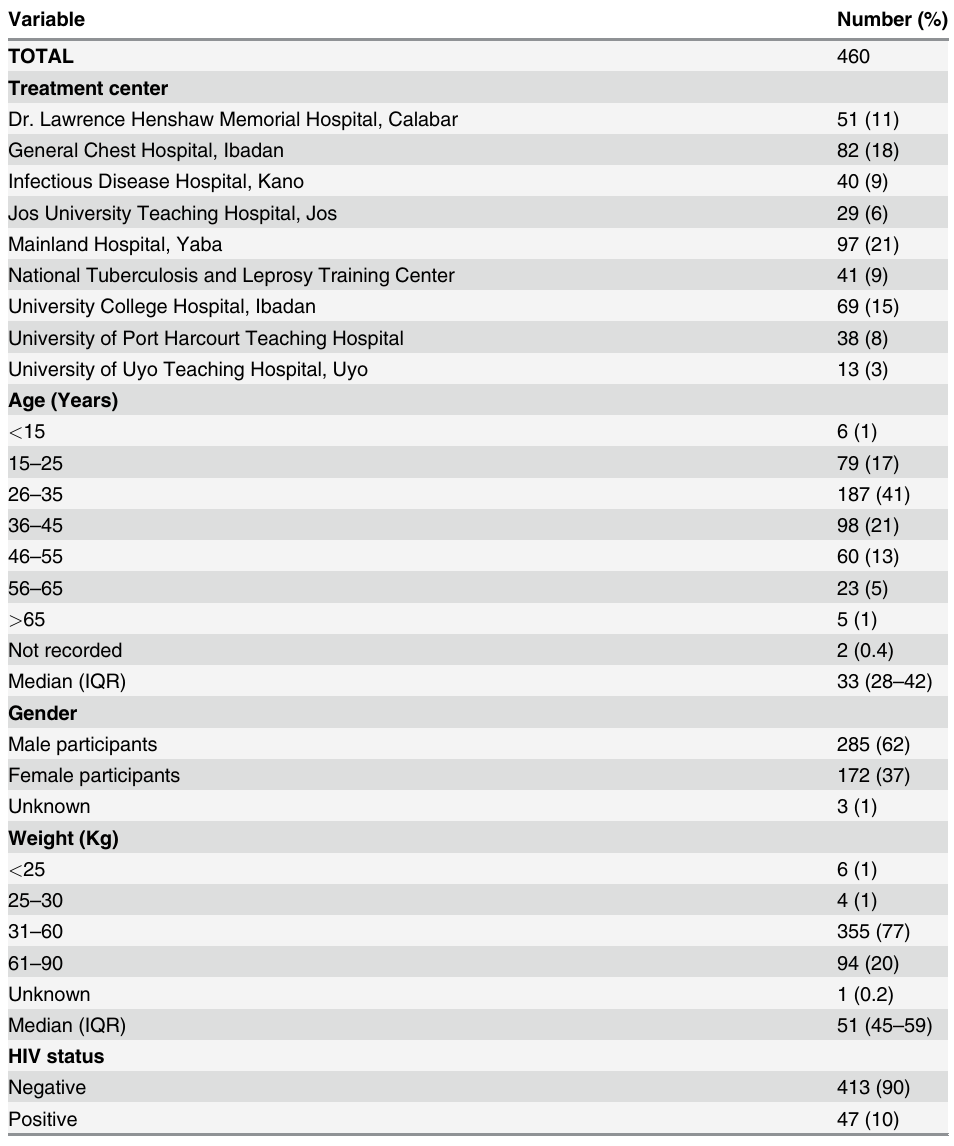
Table 3. Baseline characteristics of MDR-TB patients admitted to in-patient care, Nigeria, 2012 – 2013 (N =